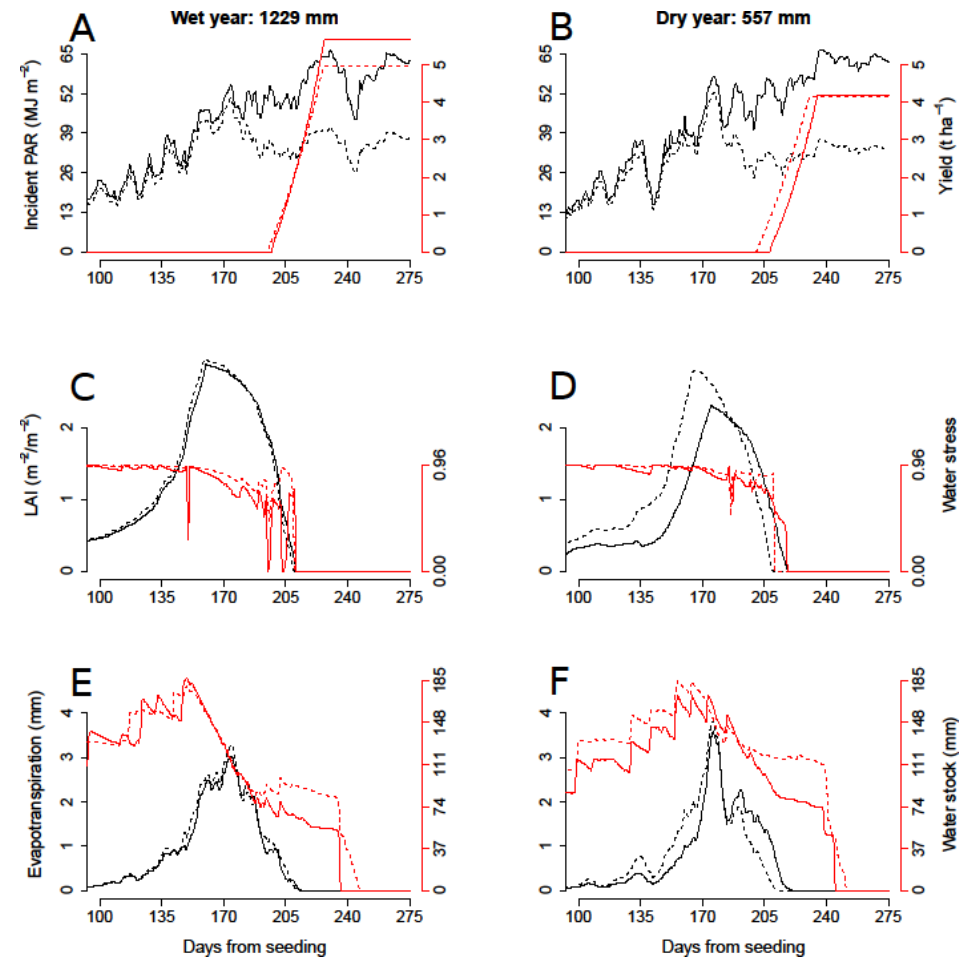
Figure 2. Physiological drivers of crop yield in a wet ( A , C , E ) and a dry year ( B , D , F ) across systems (solid lines represent monoculture, dashed lines represent alley cropping, black lines correspond to the left vertical axis, red lines to the right ones). (Top) Photosynthetically active radiation (PAR, black) incident on crops and crop yield (over the whole plot surface, red); (middle) crop leaf area index (LAI, black) and crop stomatal water stress index (red) ranging from 1: No stress, to 0: Full stress; (bottom) crop evapotranspiration (black) and water stock available for crops in the crop root zone (red). Values are given at plot scale. Left vertical axis is for black lines, right vertical axis is for red lines. For a clearer graphical representation, the PAR incident is shown after averaging with a moving window of 7 days.